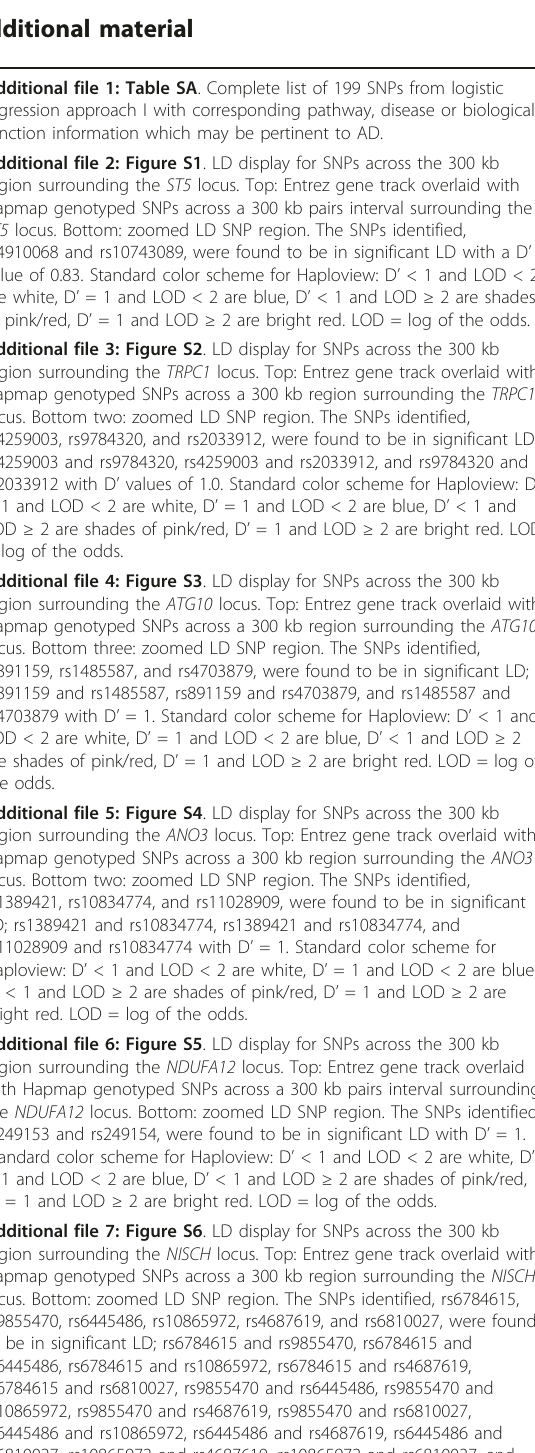
Additional file 6: Figure S5 . LD display for SNPs across the 300 kb region surrounding the NDUFA12 locus. Top: Entrez gene track overlaid with Hapmap genotyped SNPs across a 300 kb pairs interval surrounding the NDUFA12 locus. Bottom: zoomed LD SNP region. The SNPs identified, rs249153 and rs249154, were found to be in significant LD with D ’ = 1. Standard color scheme for Haploview: D ’ < 1 and LOD < 2 are white, D ’ = 1 and LOD < 2 are blue, D ’ < 1 and LOD ≥ 2 are shades of pink/red, D ’ = 1 and LOD ≥ 2 are bright red. LOD = log of the odds. Additional file 7: Figure S6 . LD display for SNPs across the 300 kb region surrounding the NISCH locus. Top: Entrez gene track overlaid with Hapmap genotyped SNPs across a 300 kb region surrounding the NISCH locus. Bottom: zoomed LD SNP region. The SNPs identified, rs6784615, rs9855470, rs6445486, rs10865972, rs4687619, and rs6810027, were found to be in significant LD; rs6784615 and rs9855470, rs6784615